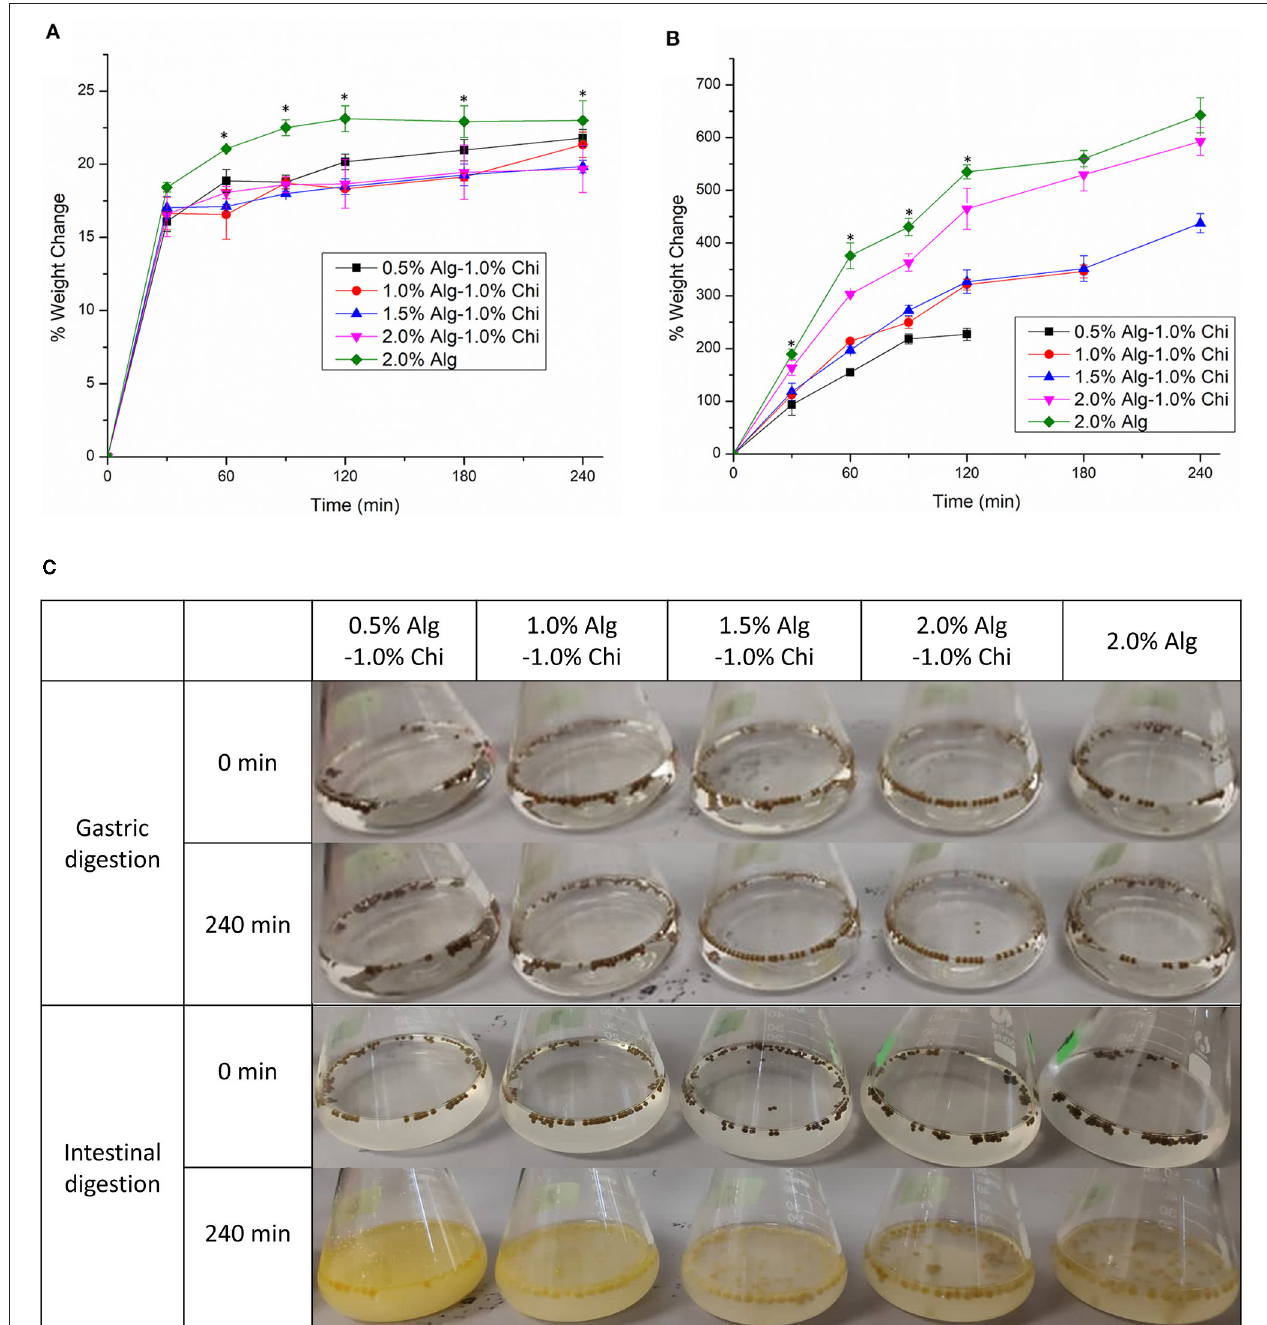
FIGURE 4 | The water uptake of alginate-chitosan hydrogel beads immobilized Pickering emulsion obtained with different alginate concentrations during (A) gastric digestion (B) intestinal digestion. (C) The visual appearance of beads before and after gastric and intestinal digestion. Error bars represent the standard deviation of three replicates. *Marks significant differences ( p < 0.05). A comparison was made between 2.0% Alg and 2.0–1.0% Chi.